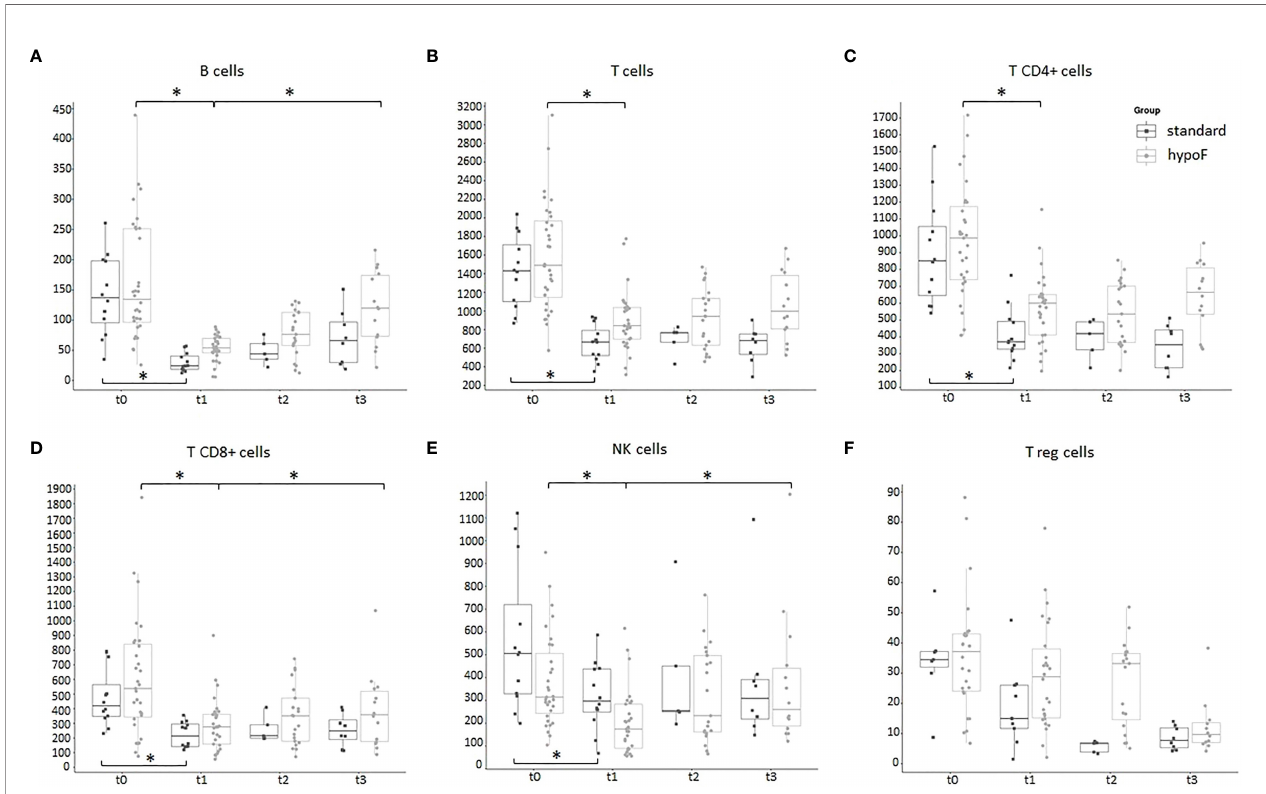
FIGURE 6 | Boxplots of the peripheral immune cell subpopulation values, expressed as cells/µl, in standard ( n = 12) and hypoF ( n = 32) RT groups during the four time points considered. (A) CD19+ B cells; (B) CD3+CD16-CD56- T cells; (C) CD4+CD3+ T helper cells; (D) CD8+CD3+ T cytotoxic cells; (E) CD3-CD16+CD56+